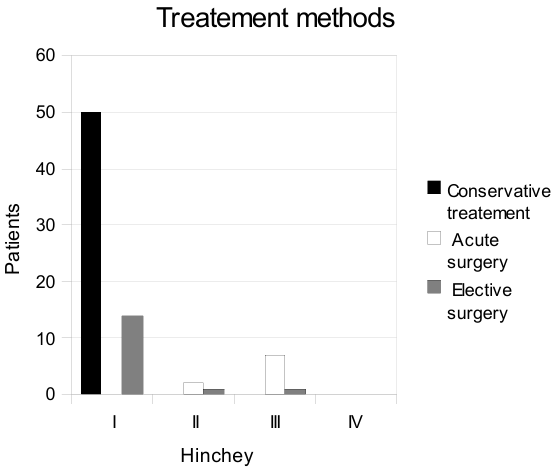
Figure 1. Treatment methods depending on Hinchey